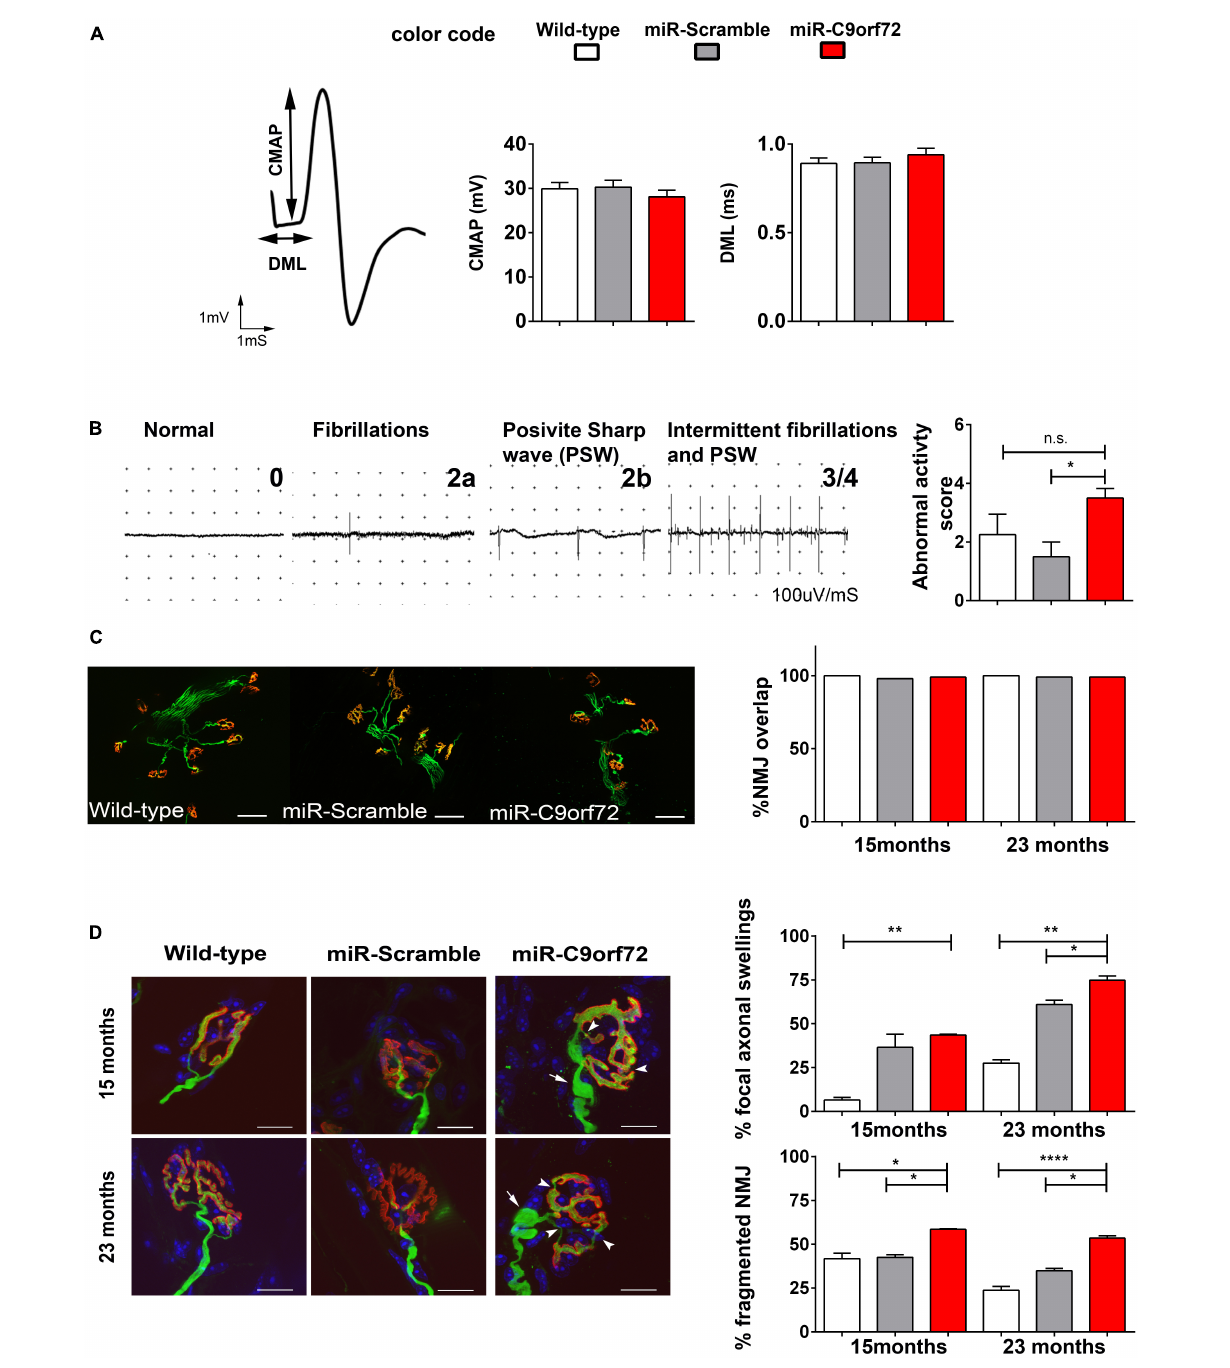
FIGURE6 C9ORF72 deficient mice show evidence of mild neuromuscular junction deficits. (A) Representative tracings of evoked Compound Muscle Action Potentials (CMAPs) at 20 months in the gastrocnemius muscle after stimulation of the sciatic nerve. Distal Motor Latency (DML), expressed in ms, was determined by the time between the stimulus and the time to onset of a negative peak in the CMAP as shown by arrows. Both graphs present DML in ms as means ± SEM and CMAP in millivolts, as means ± SEM for wild-type, miR-Scramble and miR-C9orf72 groups ( n = 8). (B) Representative tracings of abnormal activities used to score the EMG abnormal activities at 20 months: normal activity (0)/presence of abnormal activities (1) fibrillation (2a)/positive sharp wave (2b) and intermittent activities (3). The graph present EMG abnormality score rating 0 to 4 (wild-type n = 8; miR-Scramble n = 8, miR-C9orf72 n = 8). (C) Analysis of synaptic contact in diaphragm muscle of wild-type, miR-Scramble and miR-C9orf72 mice. Whole-mount preparations stained with α -bungarotoxin for acetylcholine receptors (nAChR) in red and with anti-neurofilament (NF) and anti-SV2 antibody for axons and synaptic vesicles in green. NMJ overlaps quantification shows no differences between synaptic contacts in miR-C9orf72 when compared to controls. Scale bar = 10 µ m. (D) Morphological study of NMJ in Soleus muscle of wild-type, miR-Scramble and miR-C9orf72 mice. MiR-C9orf72 mice present abnormal focal axonal swellings (arrows). The histograms represent quantification of both abnormalities expressed as a percentage of the 224, 260, and 243 NMJs analyzed in miR-C9orf72, wild-type and miR-Scramble mice, respectively. Scale bar = 10 µ m. Error bars represent SEM; n.s. non-significant; * p < 0.05, ** p < 0.01, **** p <